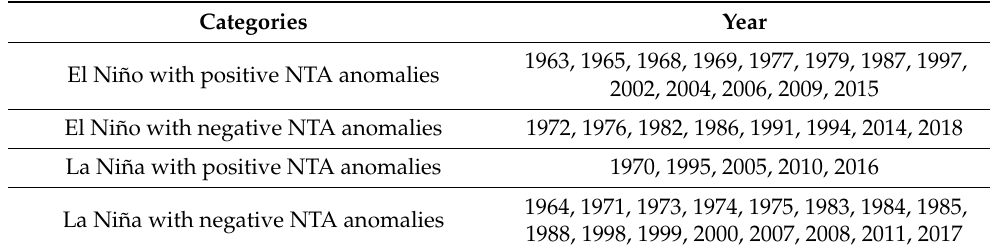
Table 1. El Niño and La Niña years are classified according to late winter NTA SST